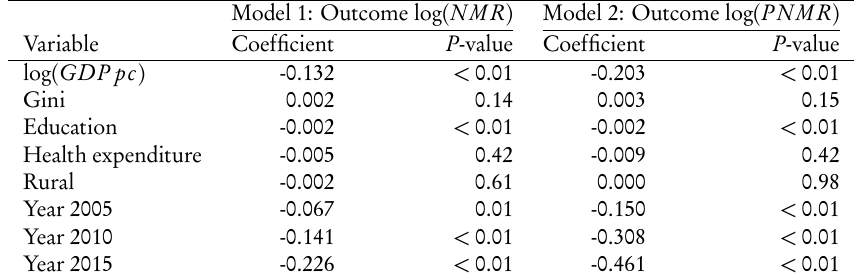
Fixed effect country-level regressions of the log neonatal and post-neonatal mortality rates; Models 1 and